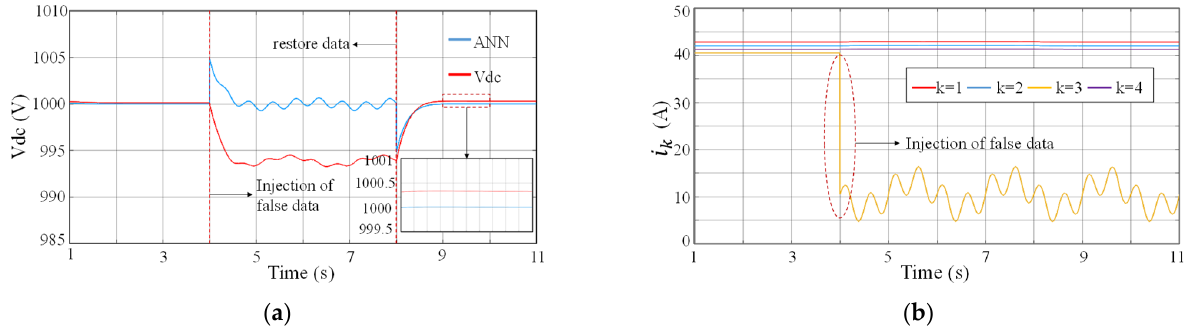
Figure 10. ( a ) Values of DC bus voltage and ANN output in case study 6; ( b ) Values of currents of the bidirectional DC ‐ DC converters in case study 6.